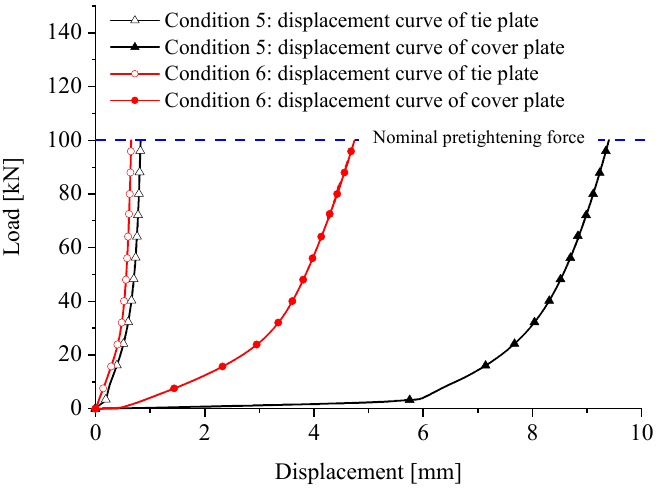
Figure 10. Comparison of the stiffness curves.